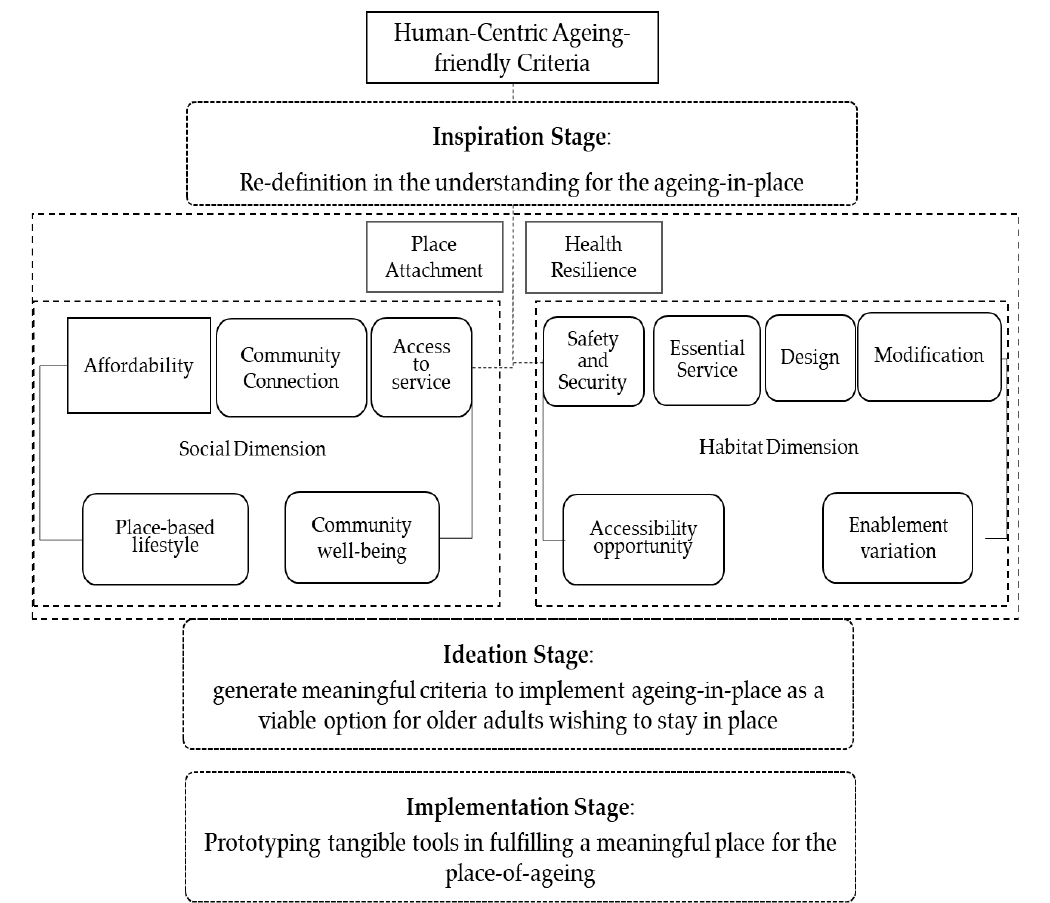
Figure 3. Revised human-centric criteria for aging-in-place. Source: modified from WHO housing- friendly checklist.